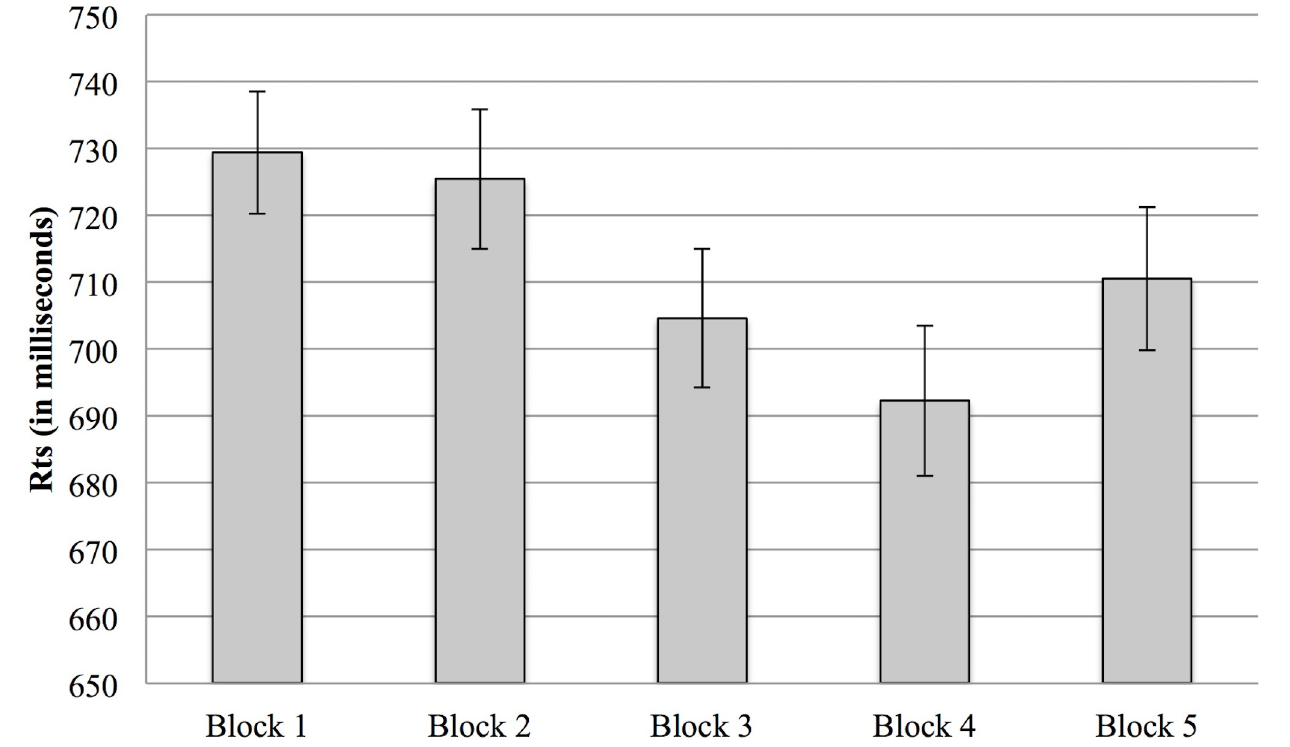
Fig 2. Reaction times (Study 1). Response reaction times in the 5 trials blocks. Note: * α < .01, ** α < .001. Error bars indicate 1 standard error above or below the mean.